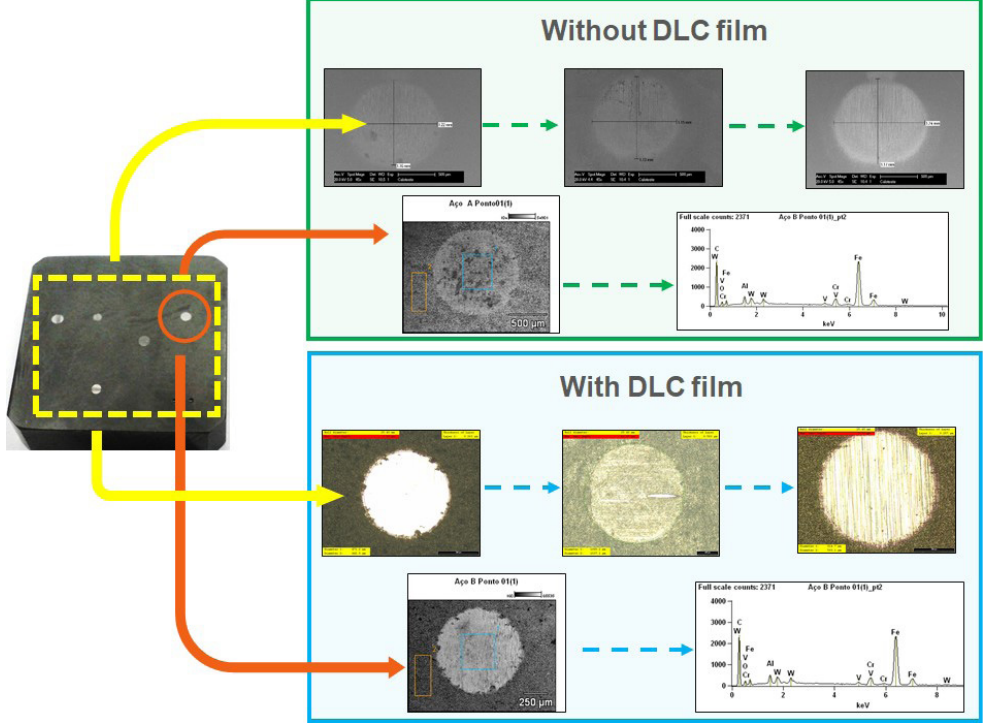
Figure 8. Craters wear analysed by